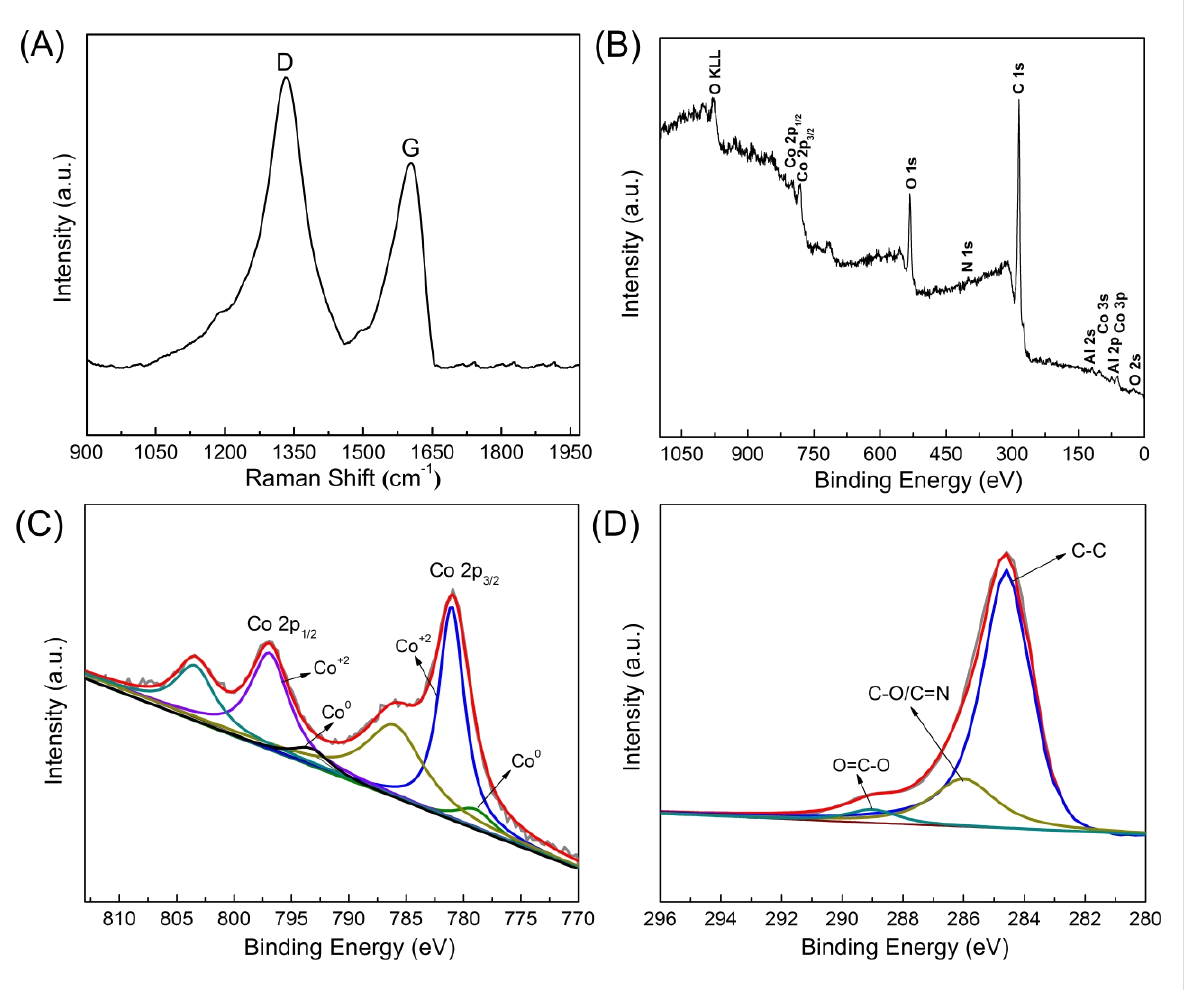
Figure 6: (A) Raman spectrum and (B–D) XPS spectra of the hexagonal magnetic mesoporous sample NPLs-2.5-800. (B) Full survey XPS spectrum, (C) high-resolution Co 2p spectrum, and (D) high-resolution C 1s